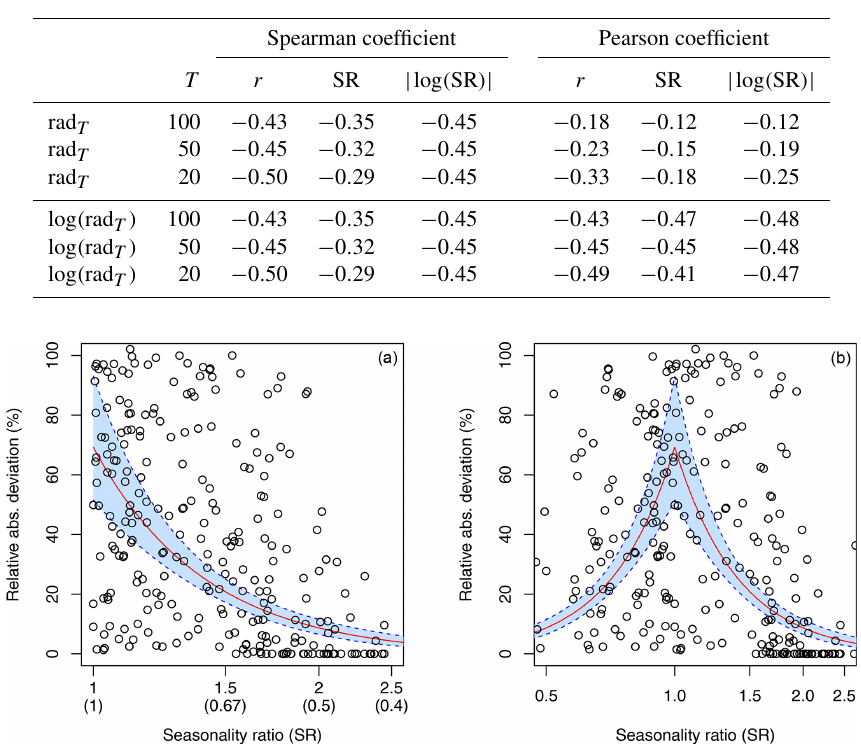
Table 3. Correlation of relative absolute deviation (rad T ) and its logarithm (log ( rad T ) ) with seasonality indices r , SR, | log ( SR ) | . All corre- lations are significant at the α = 0 . 05 level.